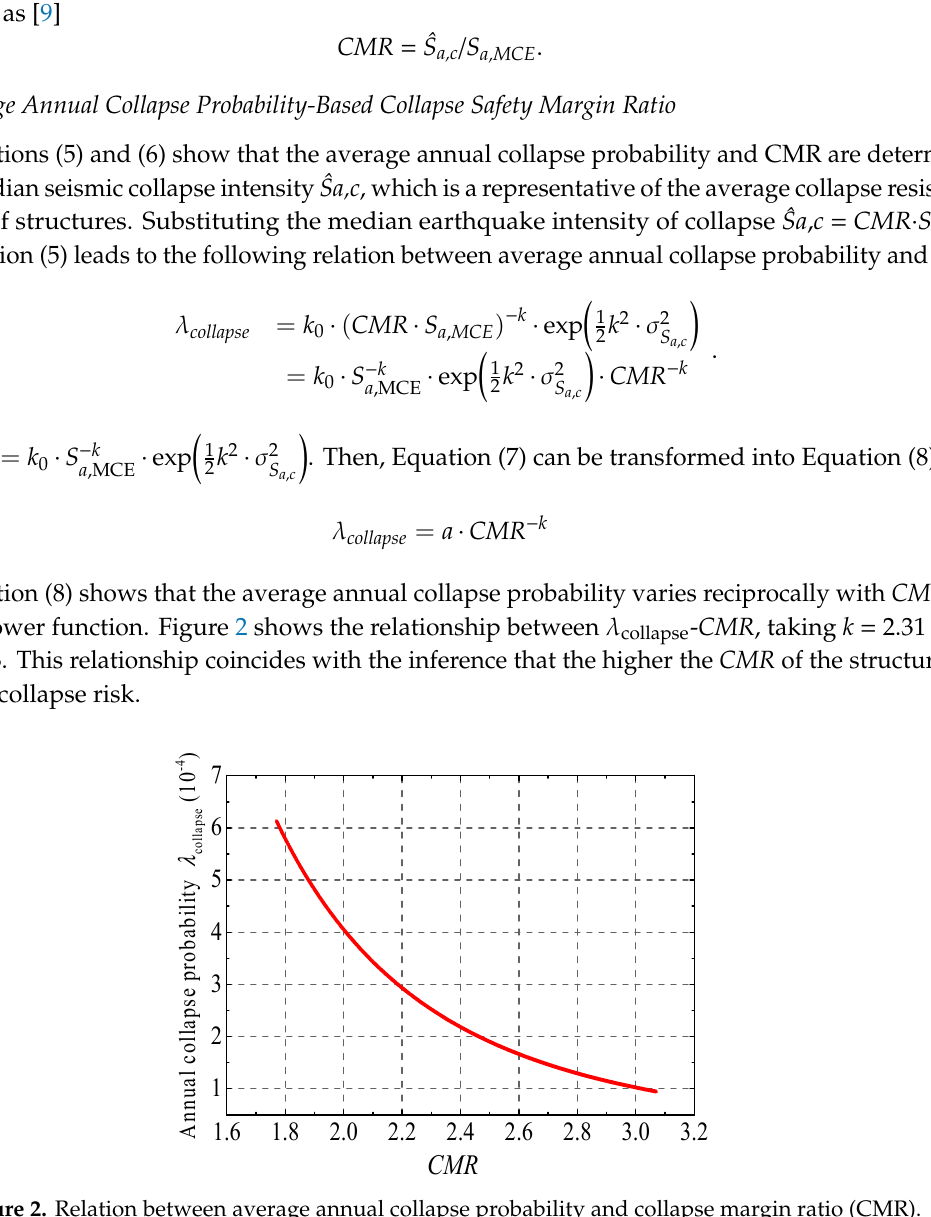
Figure 2. Relation between average annual collapse probability and collapse margin ratio (CMR ).